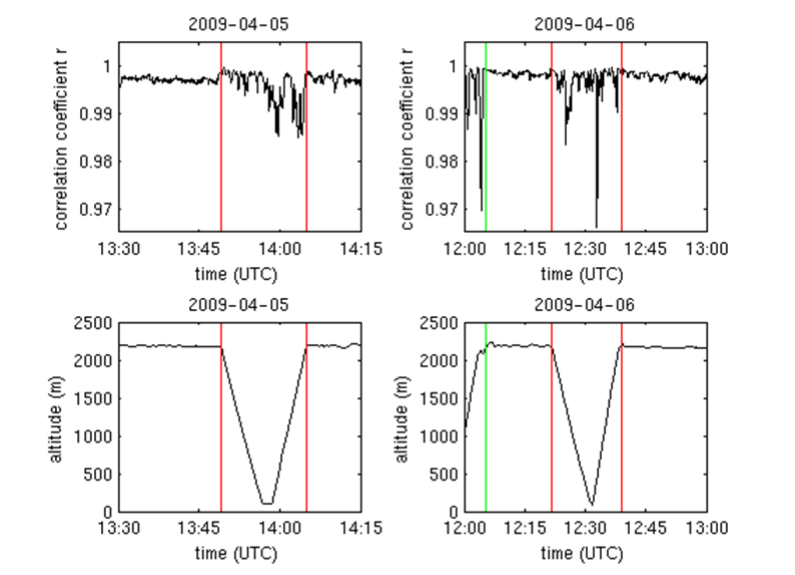
Figure 13. Correlation coefficient r between F and C (upper panels) and flight altitude sc (lower panels) on 5 (left) and 6 (right) April 2009. The red vertical lines mark the beginning of a descent and the end of a subsequent ascent during the time periods investigated. Similarly, the green vertical line marks the end of an ascent. For the horizontal flight legs, the very high correlation coefficient r with values always larger than 0.995 indicates the absence of